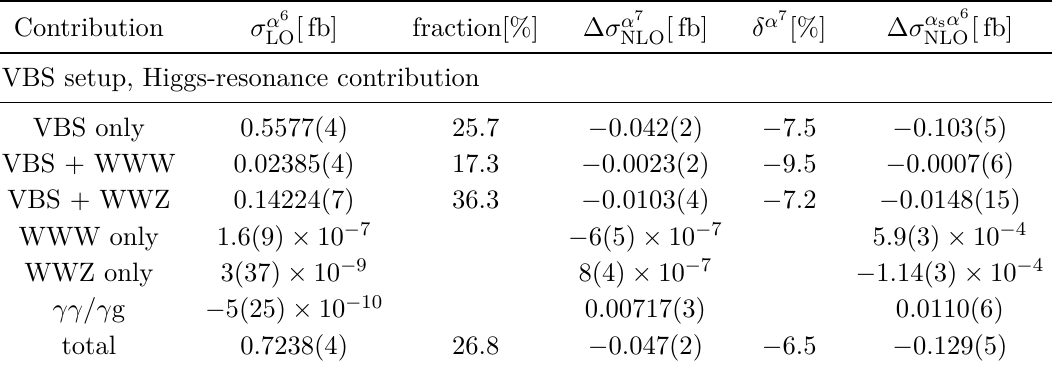
(cid:0) (cid:1) (cid:0) (cid:1) (cid:0) (cid:1) α 6 and NLO corrections at α 7 and α s α 6 in fb and relative O O O σ VBS setup, Higgs cut and the fraction of the −